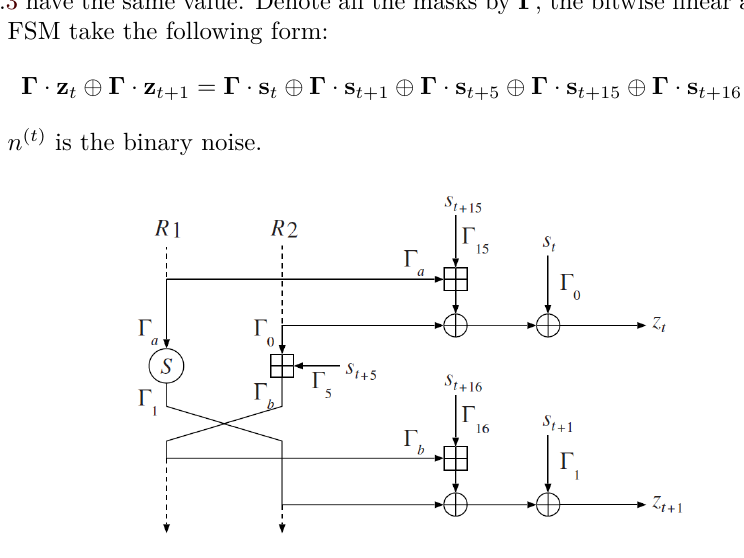
Figure 3: The two-round bitwise linear approximations for the FSM of SNOW 2.0 At FSE 2006, Nyberg and Wallén [NW06] considered the case when the output masks at time t and t + 1 are different, and used the following bitwise linear approximation relation (1) four times according to the feedback polynomial of the LFSR to build the linear distinguisher: two times with the mask tuple ( Γ , Λ ) at time t +2 and t +16, then once with the mask tuple ( Γ α, Λ α ) at time t , and finally once with the mask tuple ( Γ α − 1 , Λ α − 1 ) at time t +